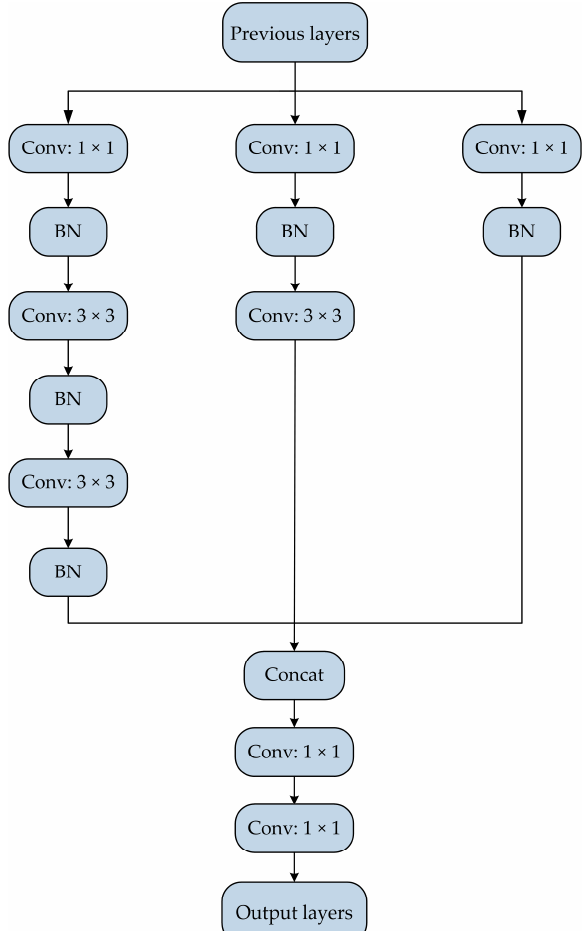
Figure 3. The internal structure of the inception block.